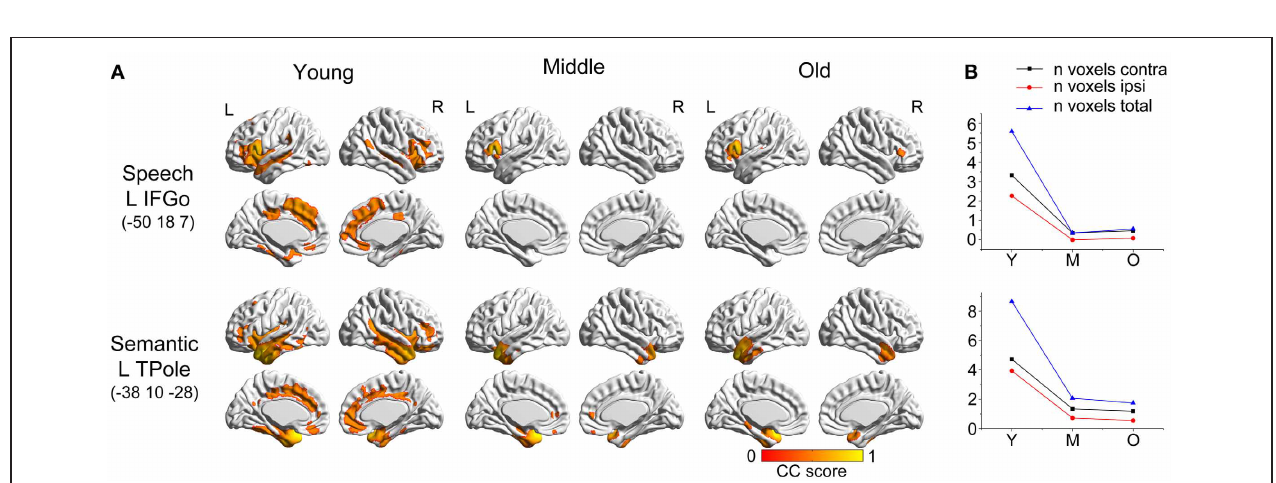
FIGURE 1 | Age-related changes in primary sensory and motor structural covariance networks. (A) Statistical maps of regions significantly correlated with the seed region in each group. The results are presented as correlation coefficient values ( P < 0 . 05, FWE corrected). (B) The plots of voxel counts by